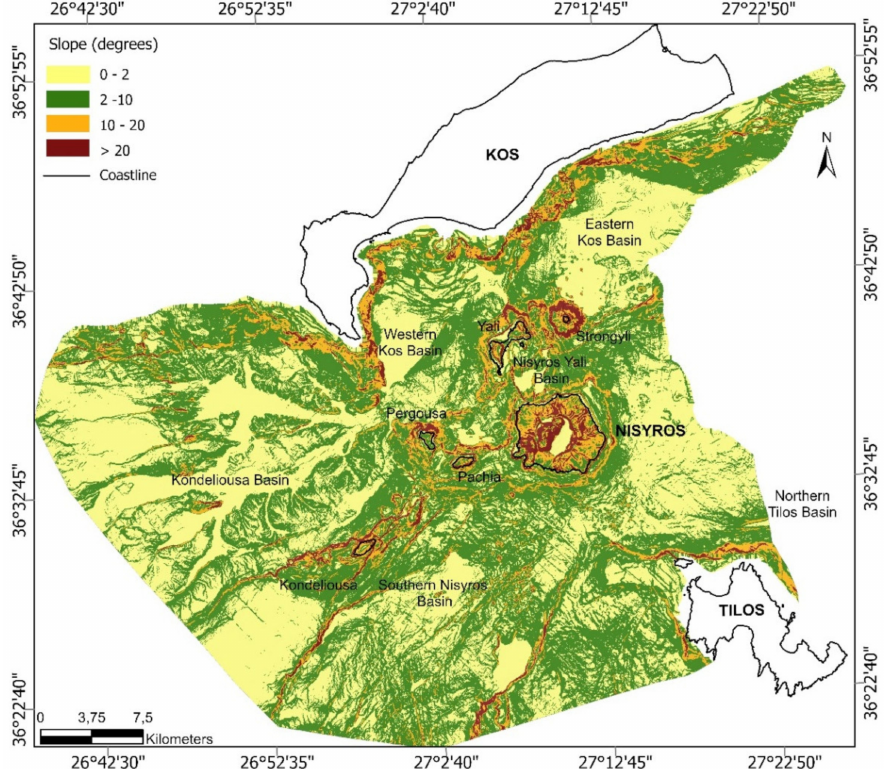
Figure 4. Morphological slope map in degrees of Kos-Nisyros-Tilos volcanic field based on onshore and offshore data. The sub-horizontal areas are well illustrated. The map has been categorized in four classes with slope values ranging from 0 ◦ to areas greater or equal than ≥ 20 ◦ .